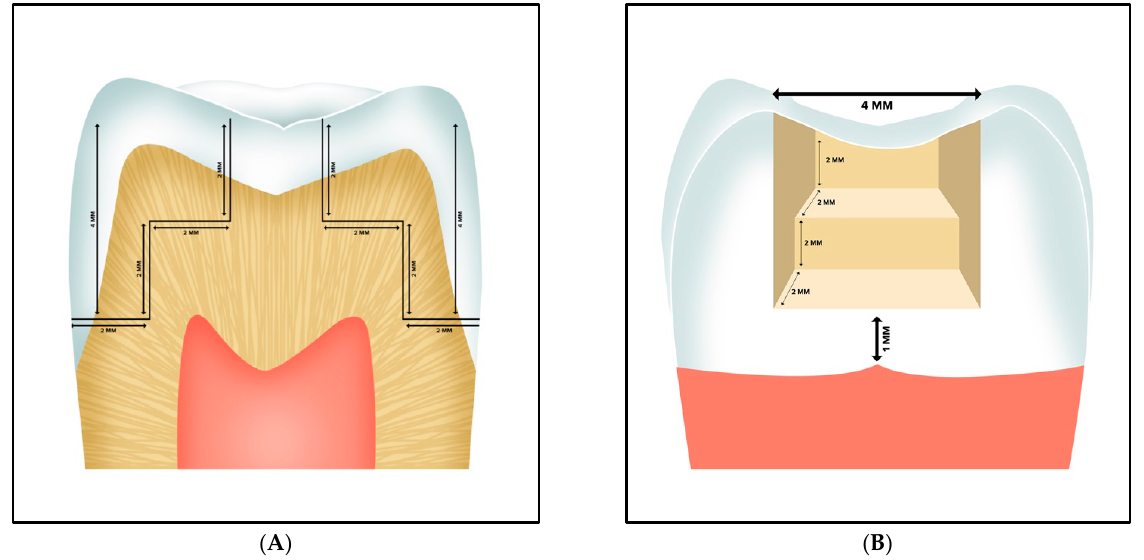
Figure 2. Class II cavity preparation. ( A ): crown sectioned lengthwise (mesiodistal direction) and ( B ) proximal view.